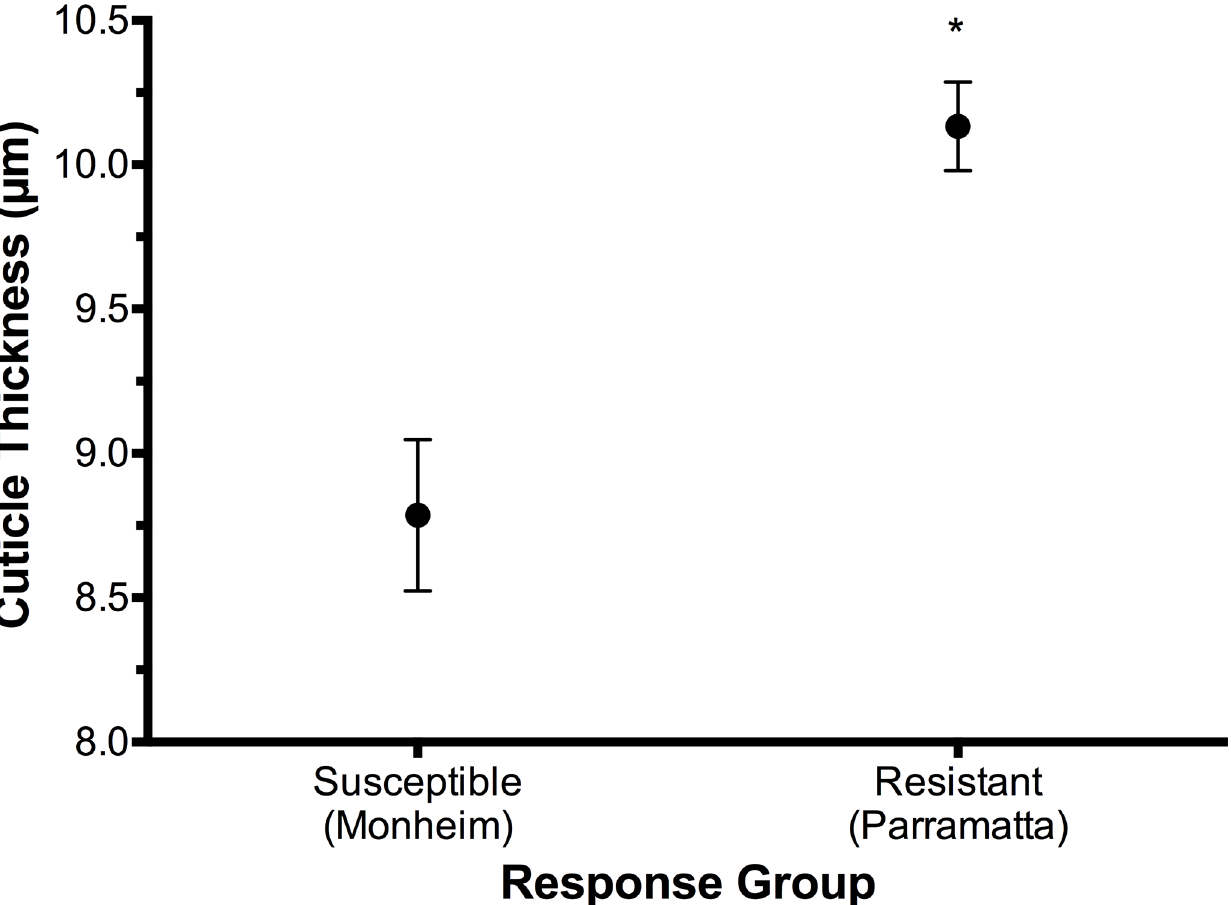
Fig 5. Mean cuticle thickness ( μ m ± S.E) of Monheim susceptible (n = 10) and Parramatta resistant (n = 10) Cimex lectularius . Asterisks ( * ) indicate statistical significance (p < 0.05).